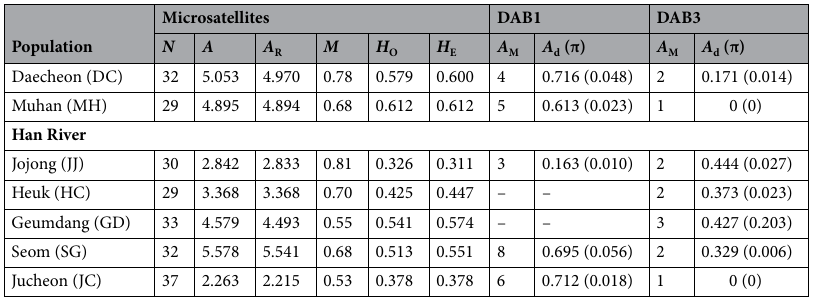
Table 1. Summary of seven Rhodeus pseudosericeus populations analyzed in this study and the microsatellite and MHC (DAB1 and DAB3) diversity estimates. The data include population (ID), total number of individuals analyzed ( N ), total number of alleles per locus ( A ), allelic richness ( A R ), observed ( H O ) and expected ( H E ) heterozygosities and M -ratio ( M ) for microsatellites and number of alleles, allelic (haplotypic; A M ) diversity ( A d ) and nucleotide diversity ( π ) for DAB1 and DAB3.